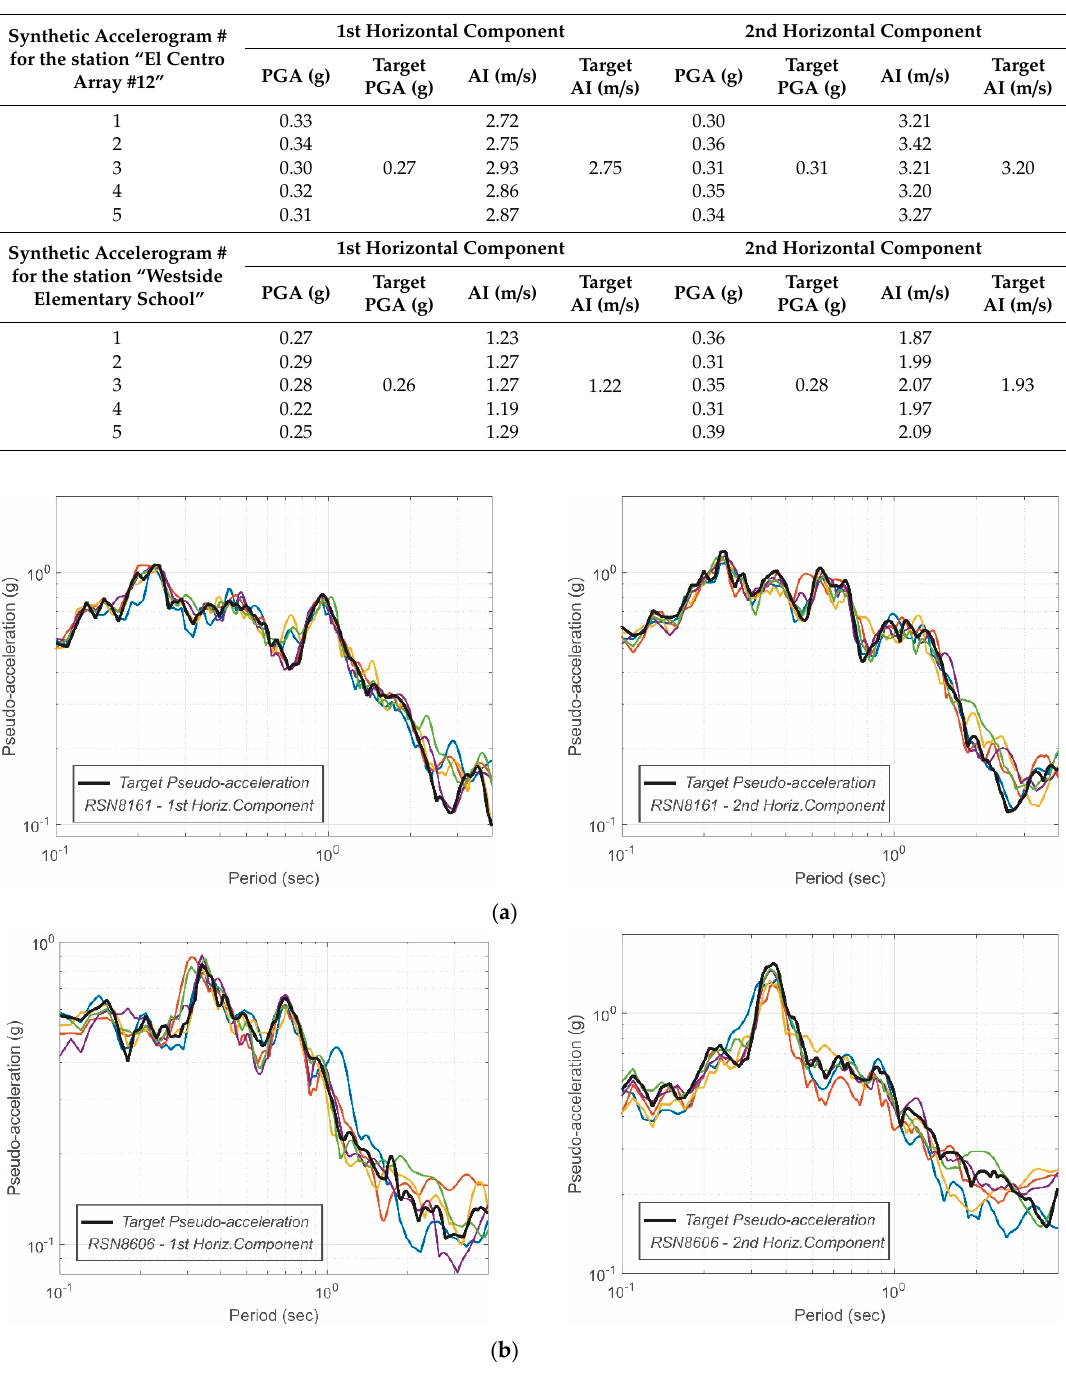
Figure 4. ( a ). Pseudo-acceleration spectrum of the real record from Table 1 for the station “El Centro Array #12” and the spectra of five corresponding synthetic acceleration time histories shown in Figure 1a, for both horizontal ground motion components. ( b ) Pseudo-acceleration spectrum of the real record from Table 1 for the station “Westside Elementary School” and the spectra of five corresponding synthetic acceleration time histories shown in Figure 1b, for both horizontal ground motion components.